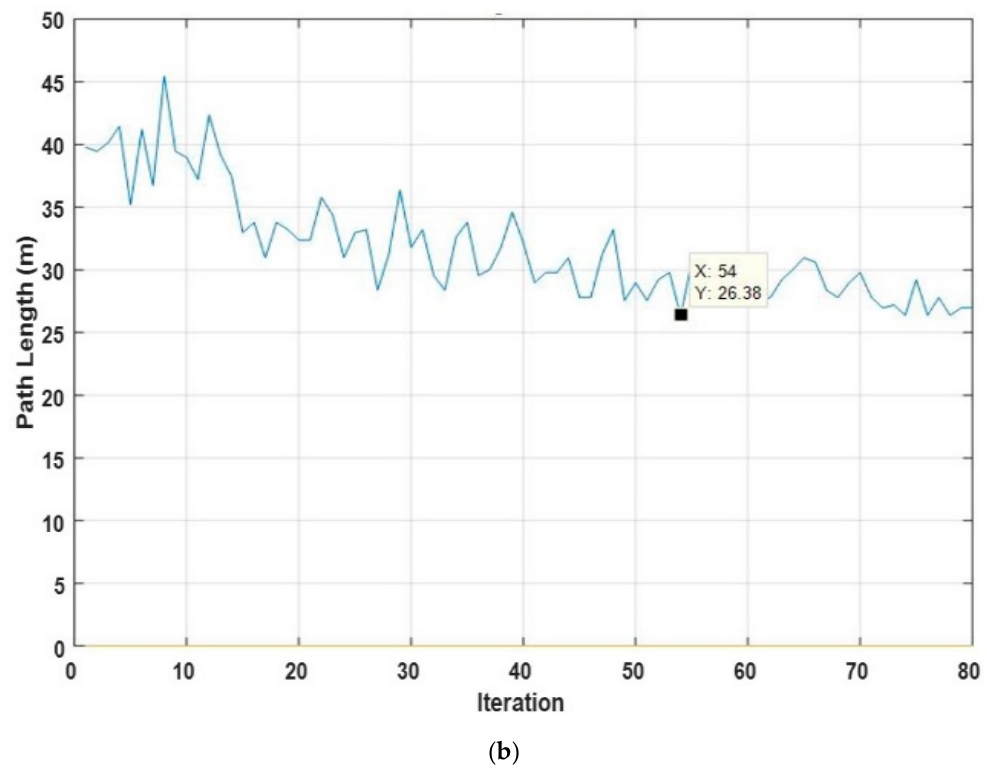
Figure 12. The best path achieved within the AACO grid-based static environment 1. Figure 12. The results of the proposed ABACO-based path planning algorithm in grid-based static environment 1, ( a ) the best path achieved, ( b ) the convergence curve of the proposed ABACO based path planning algorithm.